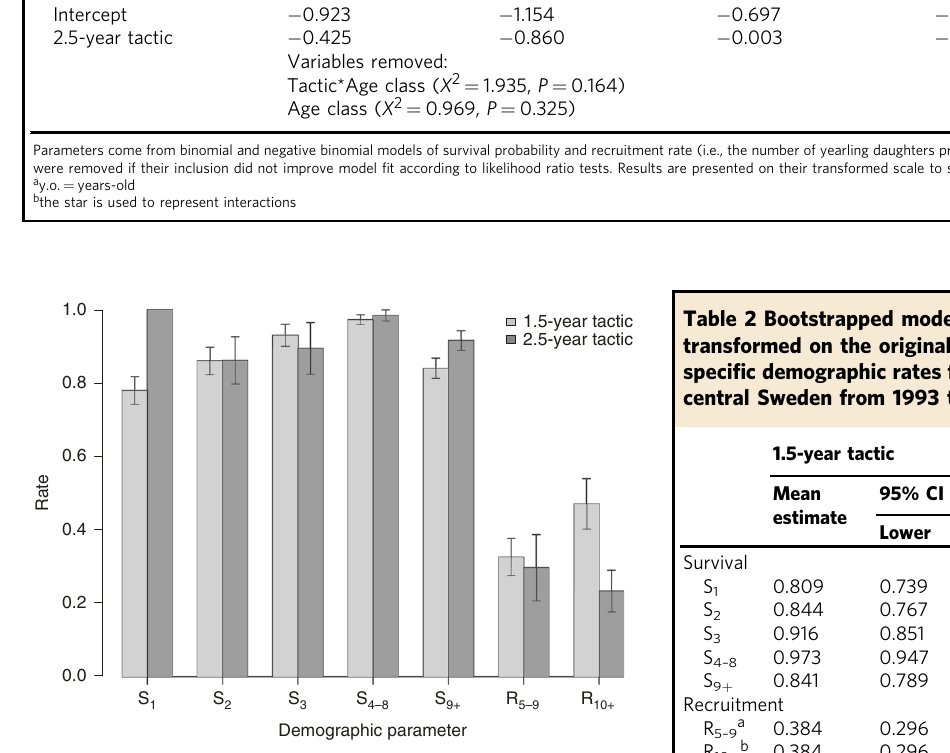
Fig. 3 Tactic and age class-speci fi c demographic parameters for female brown bears. Empirical values come from longitudinal data on female brown bears monitored in south-central Sweden from 1993 to 2015. Bars represent 95% con fi dence intervals. S is annual fi nite survival rate and R is